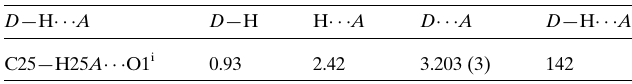
Table 2 Hydrogen-bond geometry (A˚ , (cid:2) ) for (II).